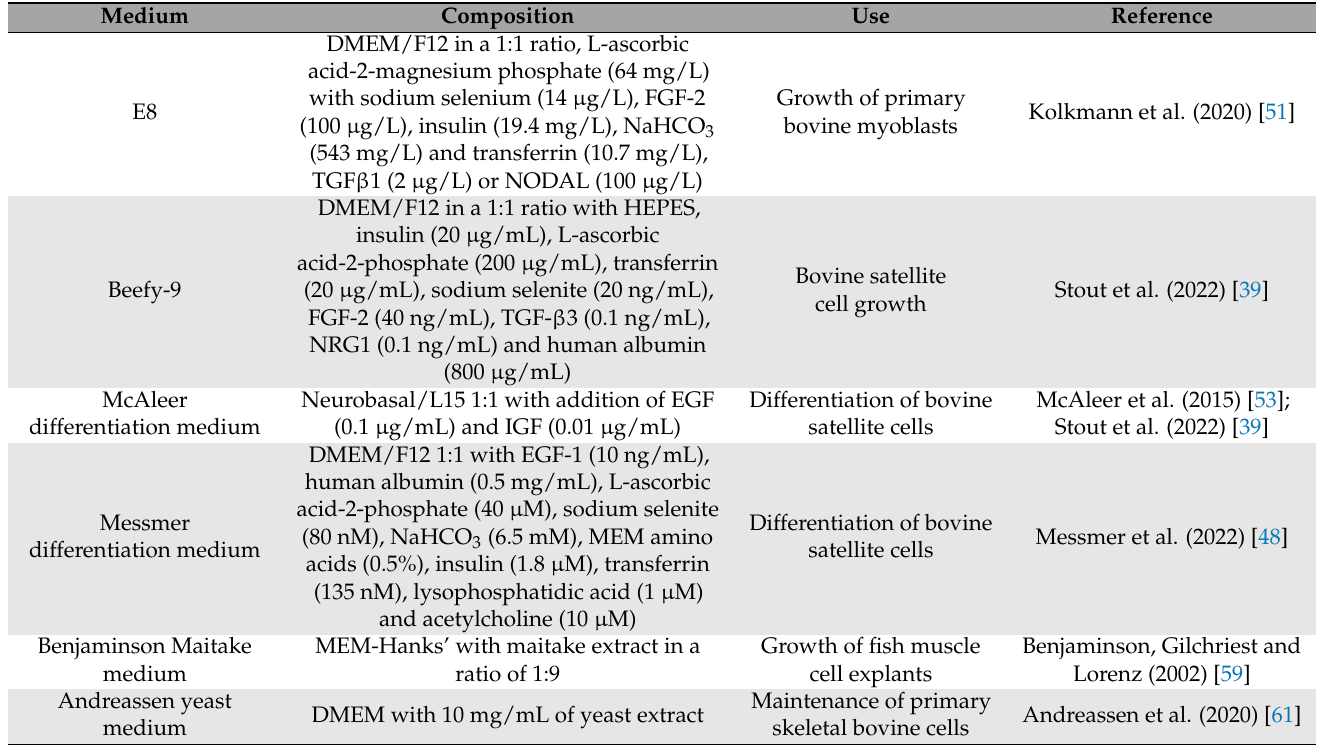
Table 2. Serum-free media: composition and